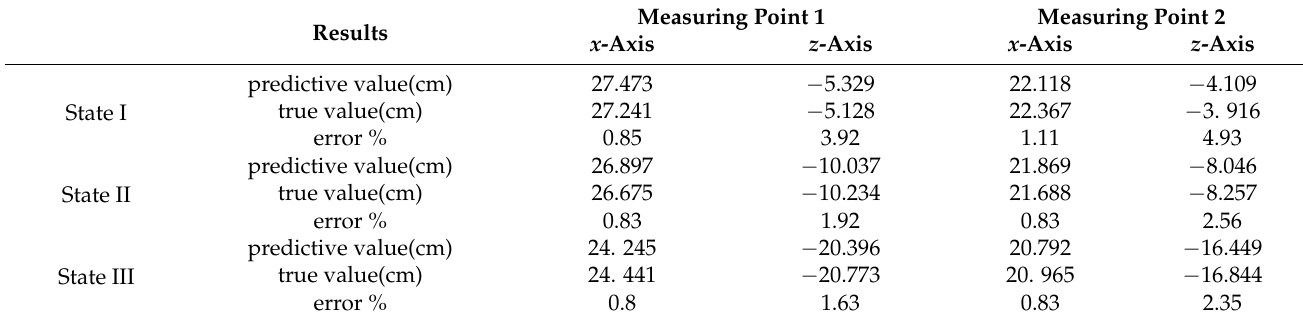
Table 7. Figure 11a comparison of measuring point results.